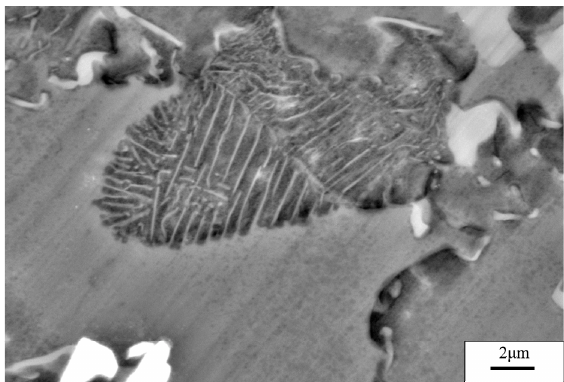
Figure 3. SEM image of the γ -Mg 17 Al 12 phase.